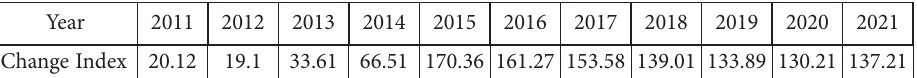
Table 1. Annual change indexes of the OPA to tourism from 2011 to 2021